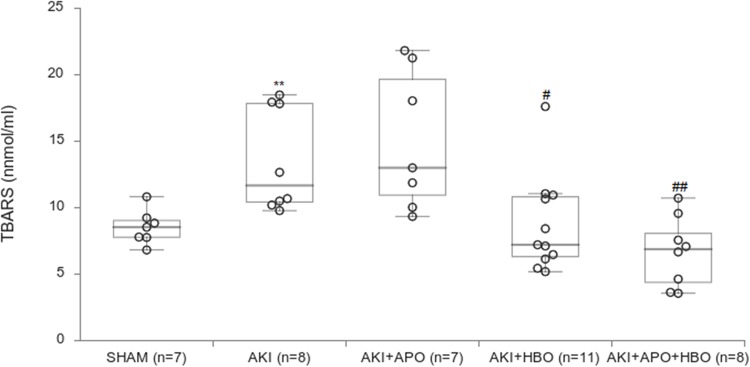
Plasma TBARS levels 24 hours after reperfusion.**p<0.01 vs. SHAM group, #p<0.05, ##p<0.01vs. AKI group.